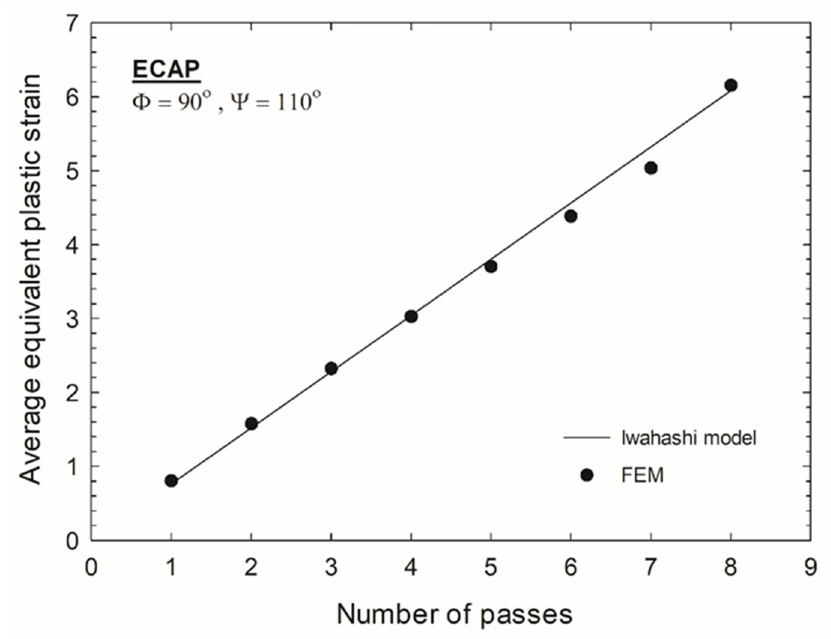
Figure 7. Average FEM simulation and the calculated equivalent plastic strains using Equation (1) from [2 ].